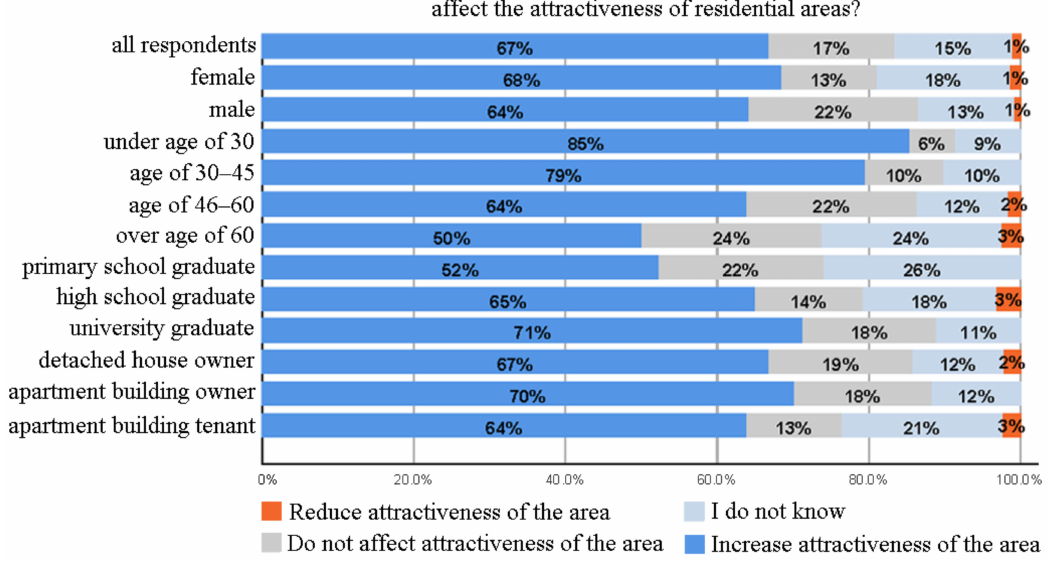
Figure 5. Effect of wooden facade renovation and additional floor construction on the attractiveness of residential areas.